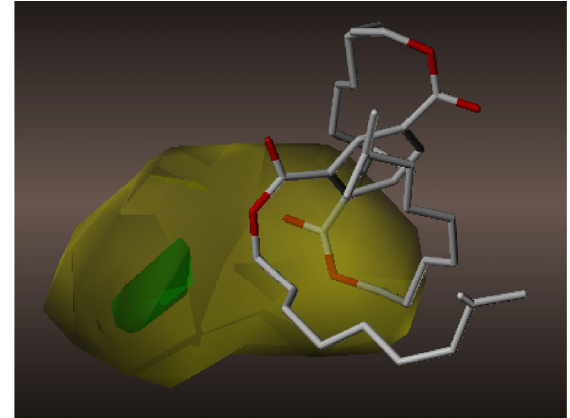
Fig. 42 CoMSIA contour diagram for friction with embedded triisodecyl trimellitate as reference for steric field. Green and yellow regions show where steric bulk is favored and disfavored,